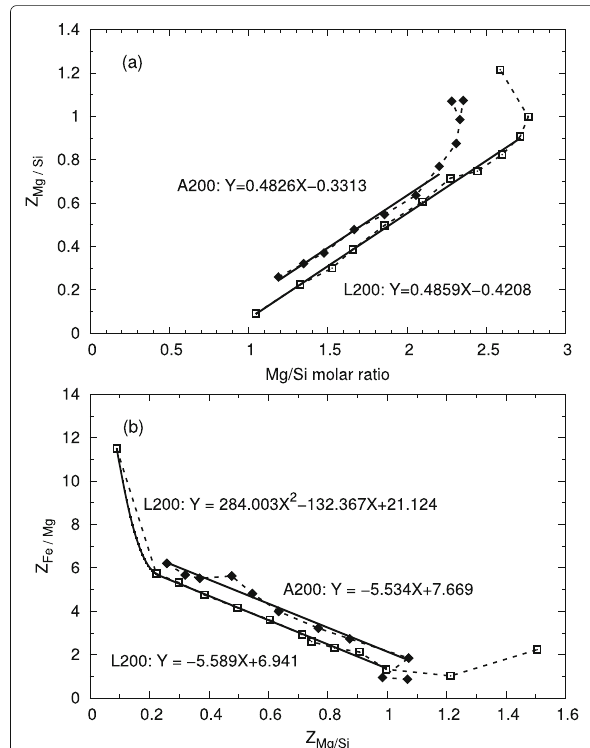
Fig. 7 a Z Mg / Si as a function of the Mg/Si molar ratio for L200 and A200. b Z Fe / Mg as a function of Z Mg / Si for L200 and A200. Each data point represents an ensemble pair in Table 4. Linear or quadratic regressions to the data are shown as solid lines, with their equations. X: abscissa. Y: